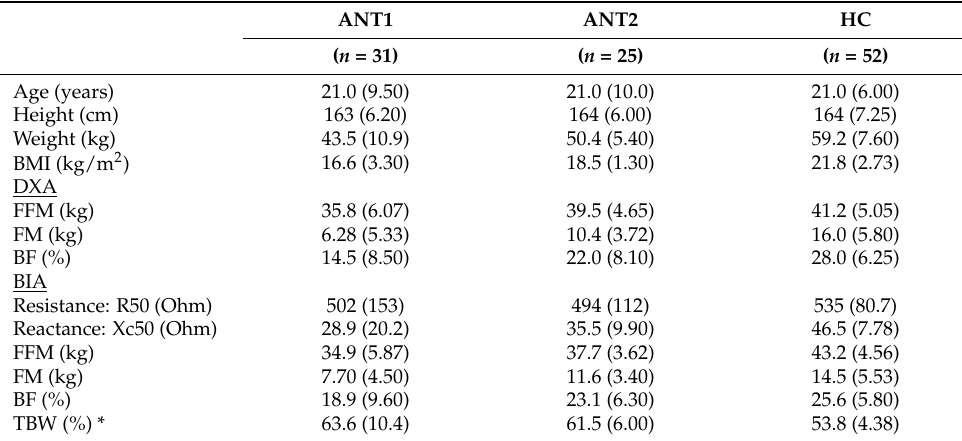
Table 1. Descriptive statistics of the